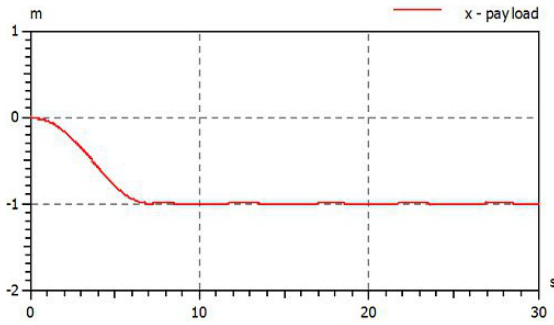
Figure 19. Set point was set to 3 m. Rise time of ca. 5 s with no overshoot, Oscillation of ± 1 cm.